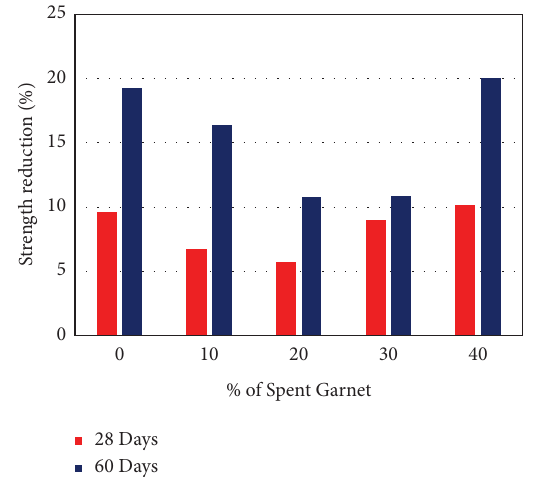
Figure 23: Strength reduction of POC LWAC due to acid attack.